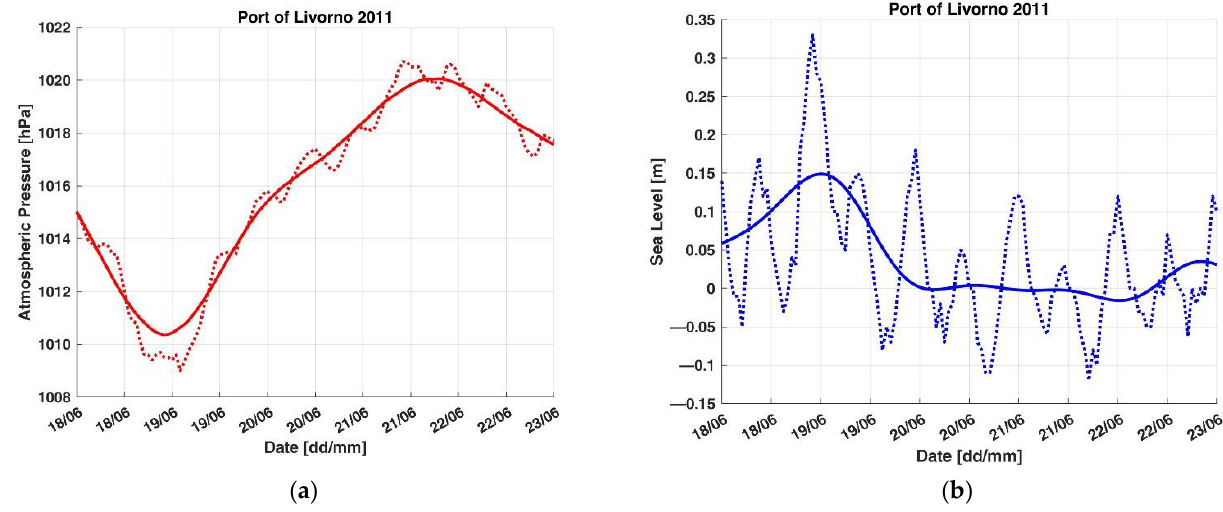
Figure A2. Low-frequency components of meteo- mareographic parameters acquired by ISPRA’s monitoring station in the port of Livorno from 18 to 23 June 2011: ( a ) atmospheric pressure; ( b ) sea level.